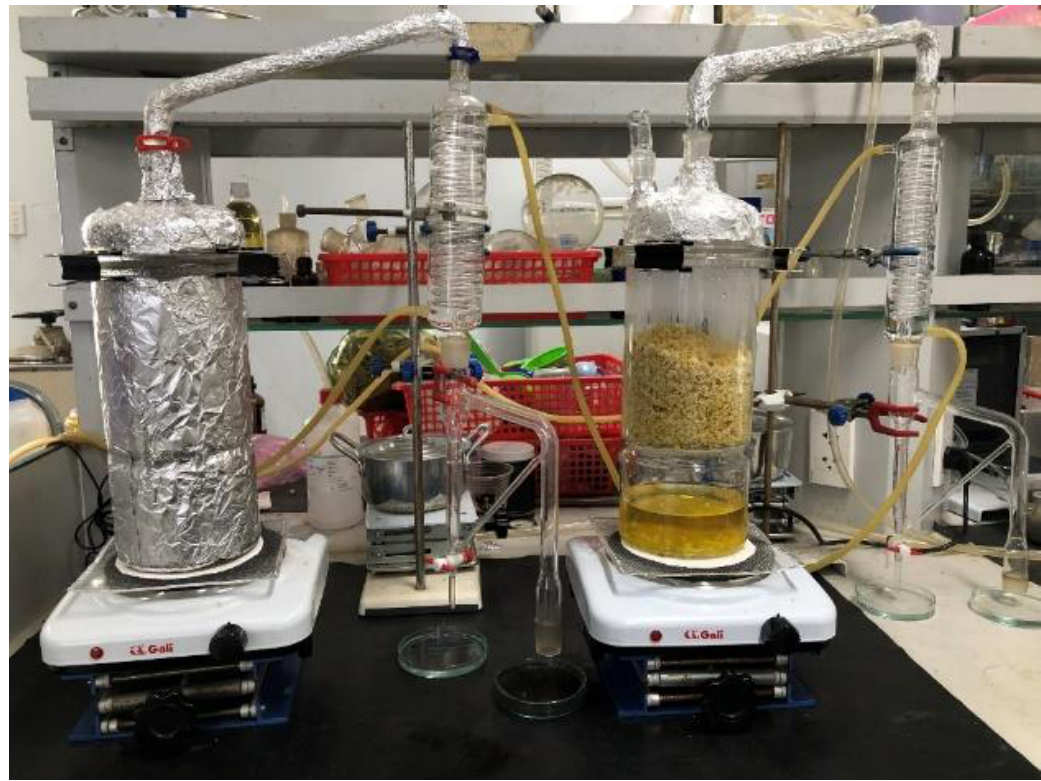
Figure 1. Steam distillation system.